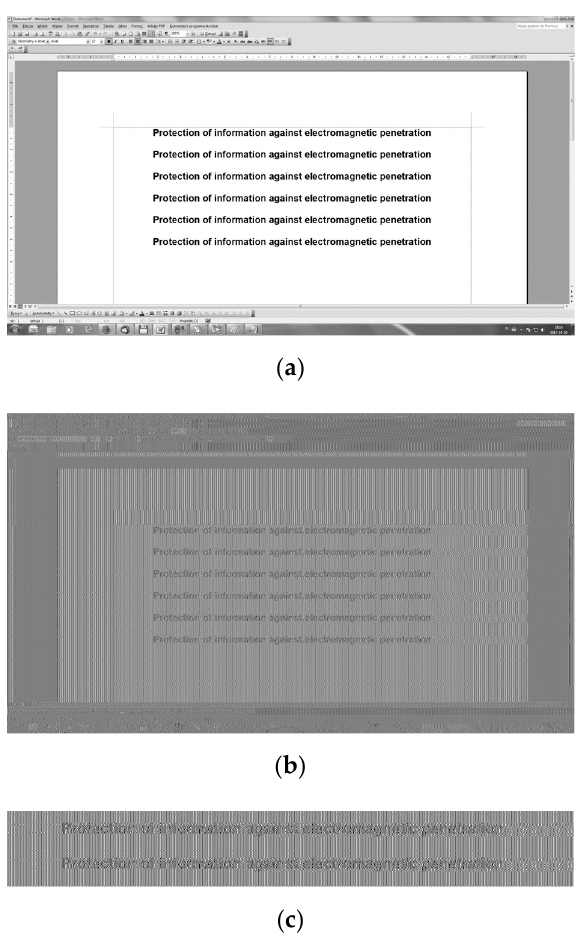
Figure 6. The original image ( a ) and the same image reproduced from the TMDS signal (without decoding) appearing on the output of graphics card ( b ), which is the source of the compromising emanations. The enlarged fragment ( c ) of the image ( b ) containing a text.